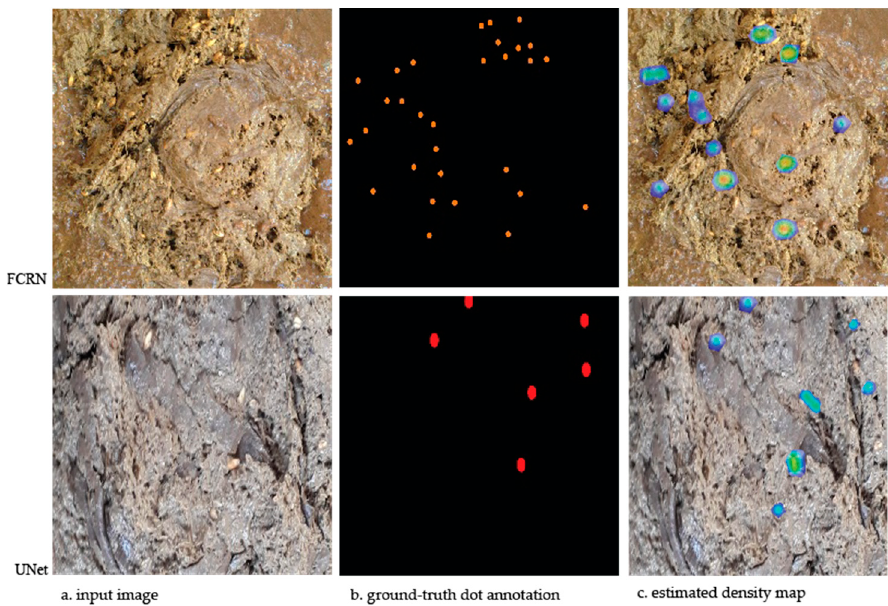
Figure 4. Comparison of two architecture on sample result. ( a ) Input images, ( b ) ground-truth dot annotations, ( c ) estimated density (heat) maps. FCRN: Fully Convolutional Regression Networks; U-Net: U-Shaped Convolutional Network.